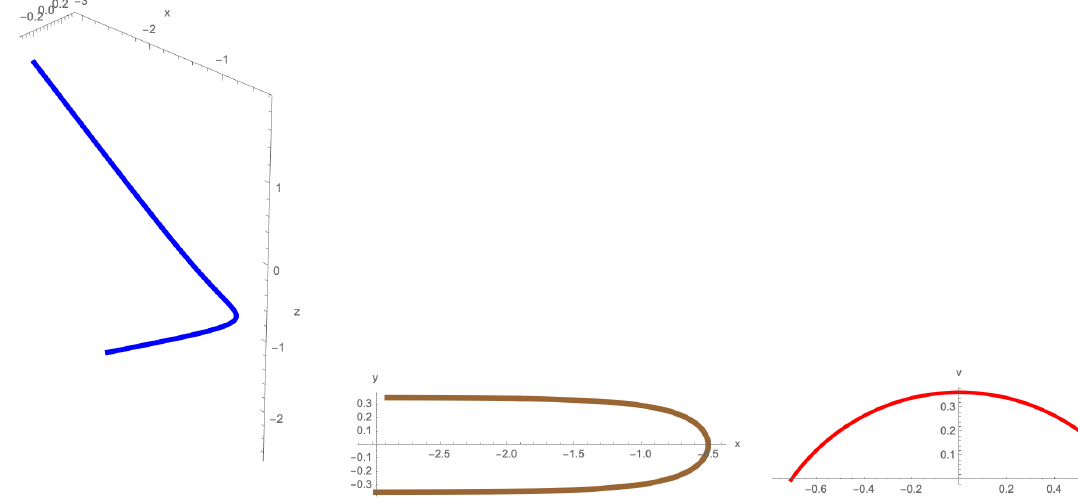
, c 0 = 0, c 1 = 0, c 2 = 3